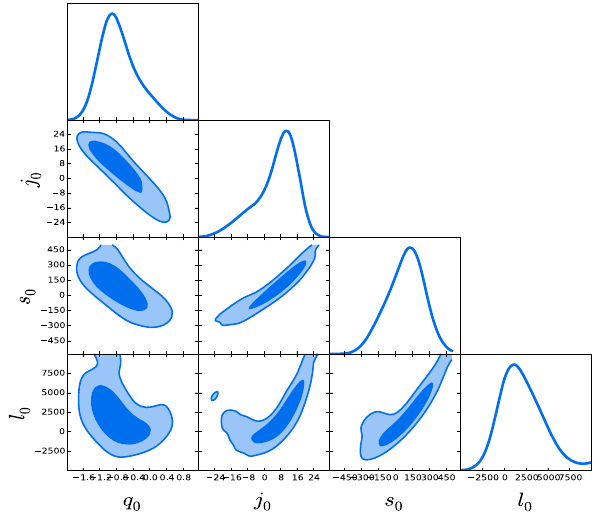
Fig. 2 Constraints on cosmographic parameters in the fourth order from the JLA compilation for y -redshift